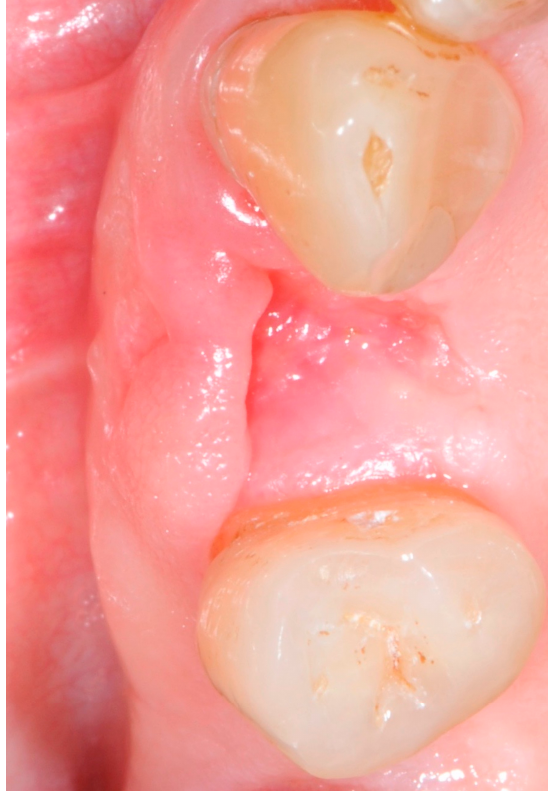
Figure 6. Clinical situation immediately after membrane removal.